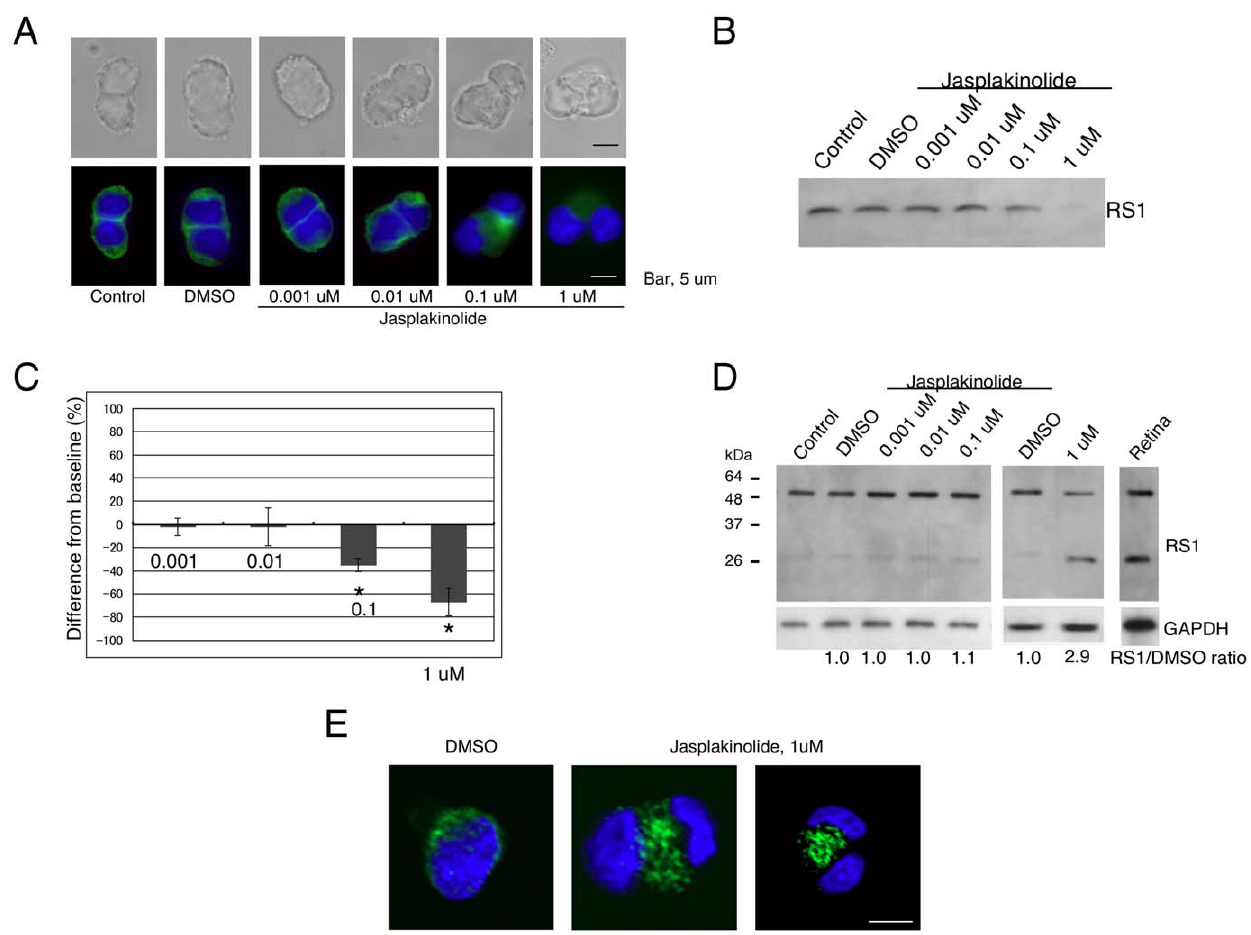
Figure 4. Retinoschisin secretion into the conditioned medium is decreased by addition of jasplakinolide. (A) Effects of jasplakinolide on cell morphology and F-actin cytoskeleton organization. Weri-Rb1 cells were cultured in medium alone (untreated control) and medium containing DMSO or the indicated concentrations of jasplakinolide for 72 h. Cells were then fixed and labeled with Alexa Fluor 488-phalloidin (green). The upper row of pictures shows transmitted light images and the lower row, fluorescent light images. Bar, 5 m m. (B) Western blot of proteins in the conditioned media of cells treated with DMSO or the indicated concentrations of jasplakinolide for 72 h using the RS24-37 antibody. As seen, retinoschisin secretion into the conditioned medium is decreased by 1 uM jasplakinolide. (C) Quantification of the intensity of each band in the Western blot in (B) (see MATERIALS AND METHODS). The data are means 6 SEM of three different biological samples for each condition. *: p , 0.05 was obtained for the difference between 1 m M jasplakinolide- and DMSO-treated cells. (D) Restinoschisin accumulates inside cells treated with 1 m M jasplakinolide. After 72 hr incubation in medium alone, medium containing DMSO or the indicated concentrations of jasplakinolide, cells were collected and analyzed by Western blot. The intensities of the dimer and monomer bands for each condition were added and normalized to GAPDH. The normalized values were then compared to that of DMSO-treated cells and are shown as RS1/DMSO ratios. (E) Retinoschisin accumulates within cells treated with 1 m M jasplakinolide. Cells were treated with DMSO or 1 m M jasplakinolide for 72 h. Cells were then fixed and incubated with RS24-37 antibody followed by Alexa Fluor 488 goat anti-rabbit IgG. Nuclei were labeled with DAPI.